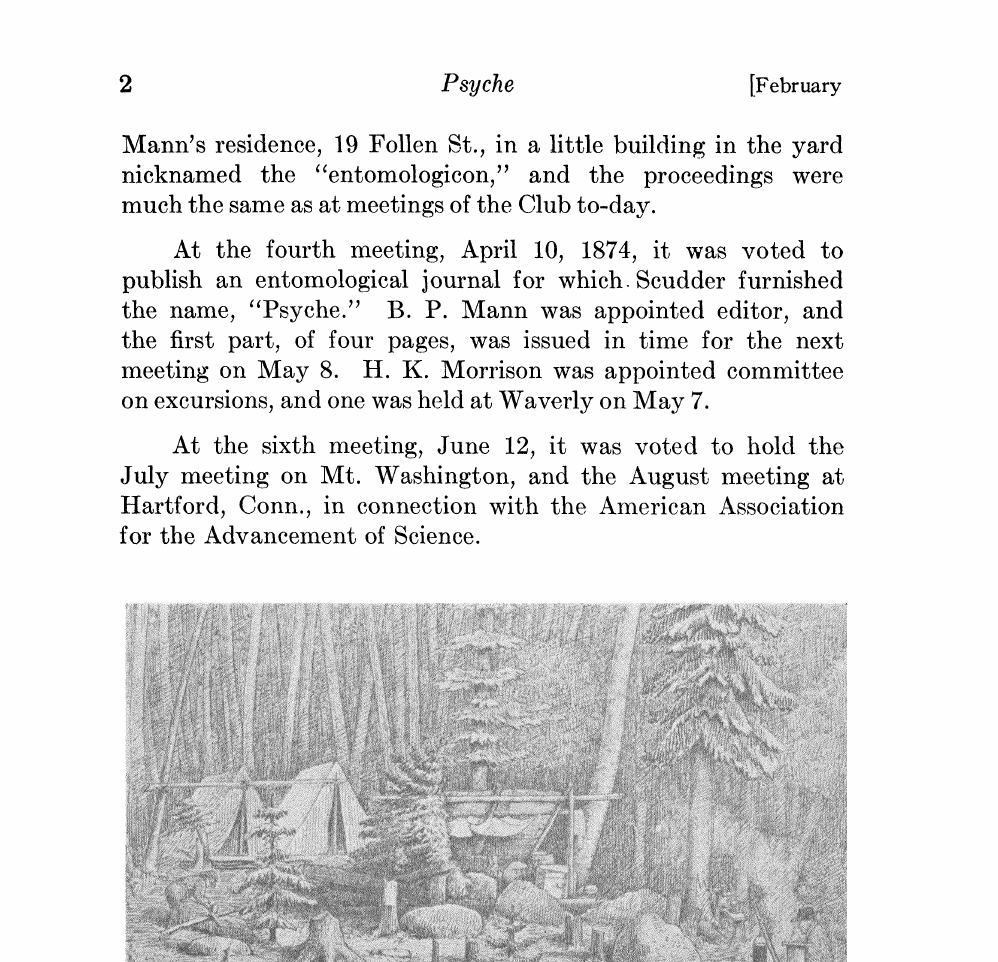
Fig. 1. Camp of the Cambridge Entomological Club on Mount Washington, July 1874, tom a drawing by J. H.